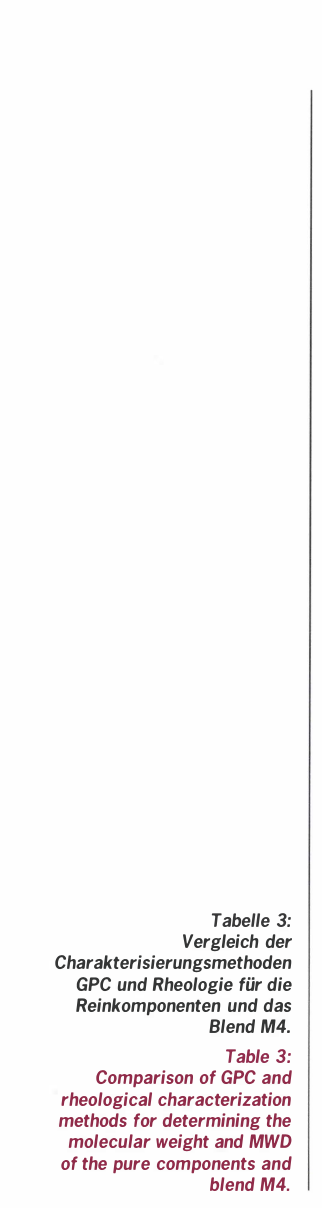
Fig. 6: Relaxationfunktionen G(t} fur PMMA45 und PMMA150 sowie das Blend M4 Fig.6. Relaxation function G(t} for PMMA45, PMMA150, and the blend